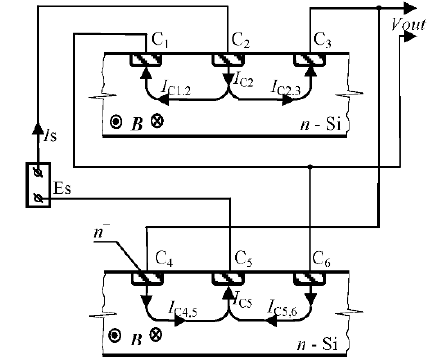
Figure 1. The novel Hall arrangement.